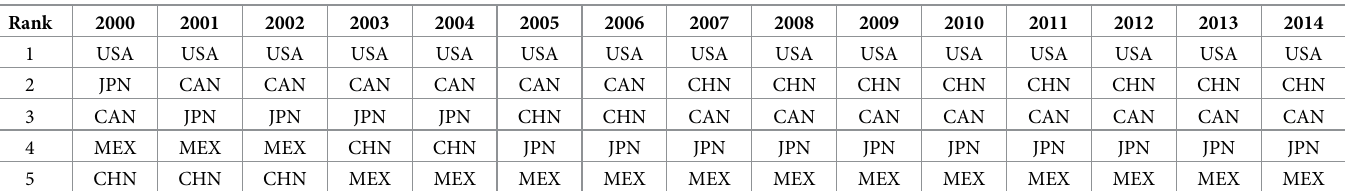
Table 13. Five highest-circulated countries in the Pacific Rim community.